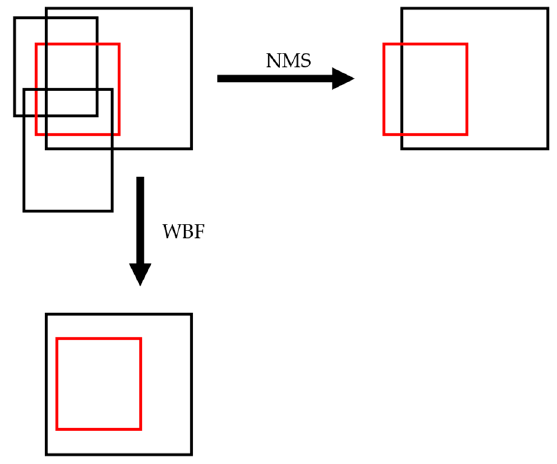
Figure 7. A comparison of the results of NMS and WBF.